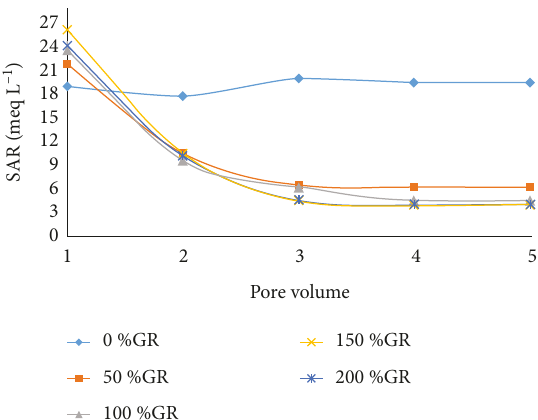
Figure 3: Mean value of cumulative leachate losses of SAR at an increasing PG